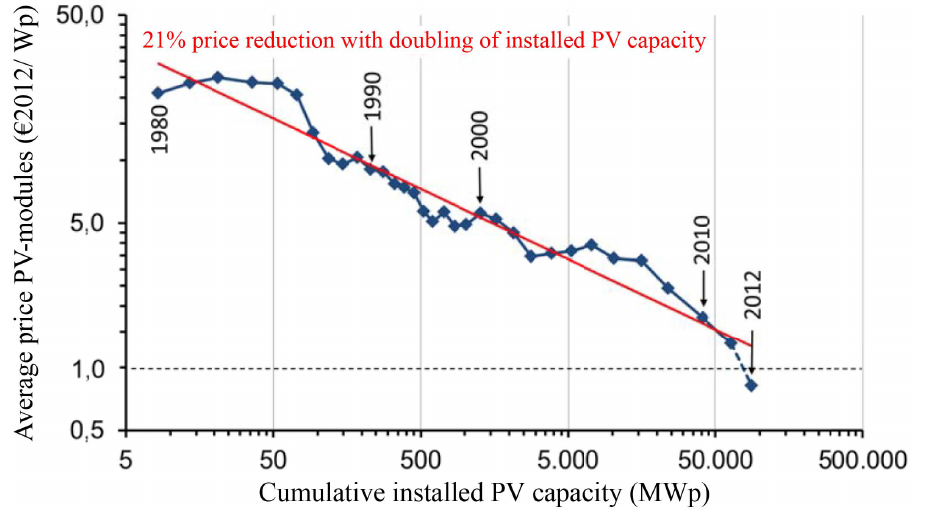
Figure 1. Worldwide cumulative installed PV capacity and historical development of PV-module prices (inflation-adjusted in Euro on 2012 level, in [6]). The straight red line shows the trend of price development for